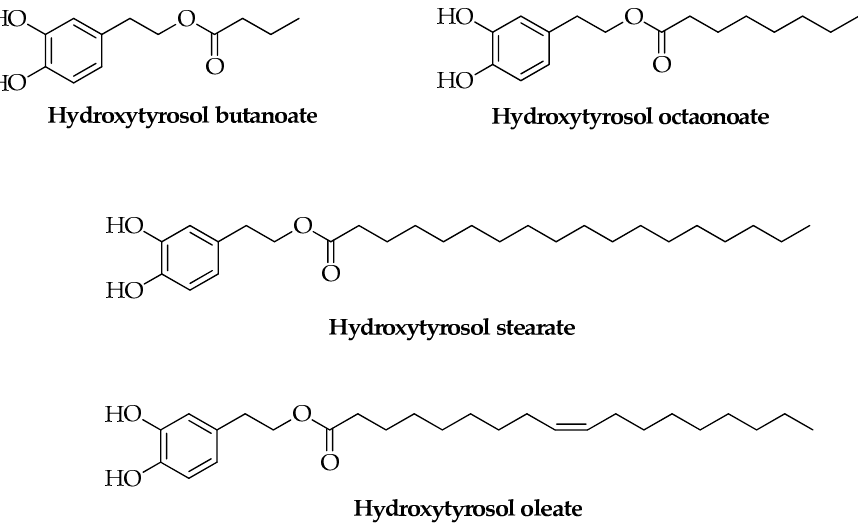
Figure 5. Lipophilic HT derivatives .